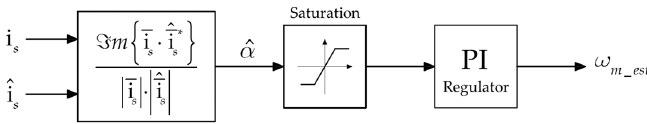
Figure 2. Speed estimation block diagram.